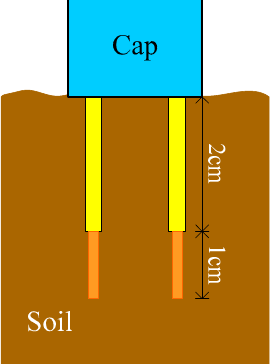
Figure 3. The sensing probe is redesigned for prolonging the operation time. Frequently replacing the rusted probe increases the error bias on moisture sampling. It is because replacing the probe usually changes the soil density and the position of the monitoring depth layer of soil.